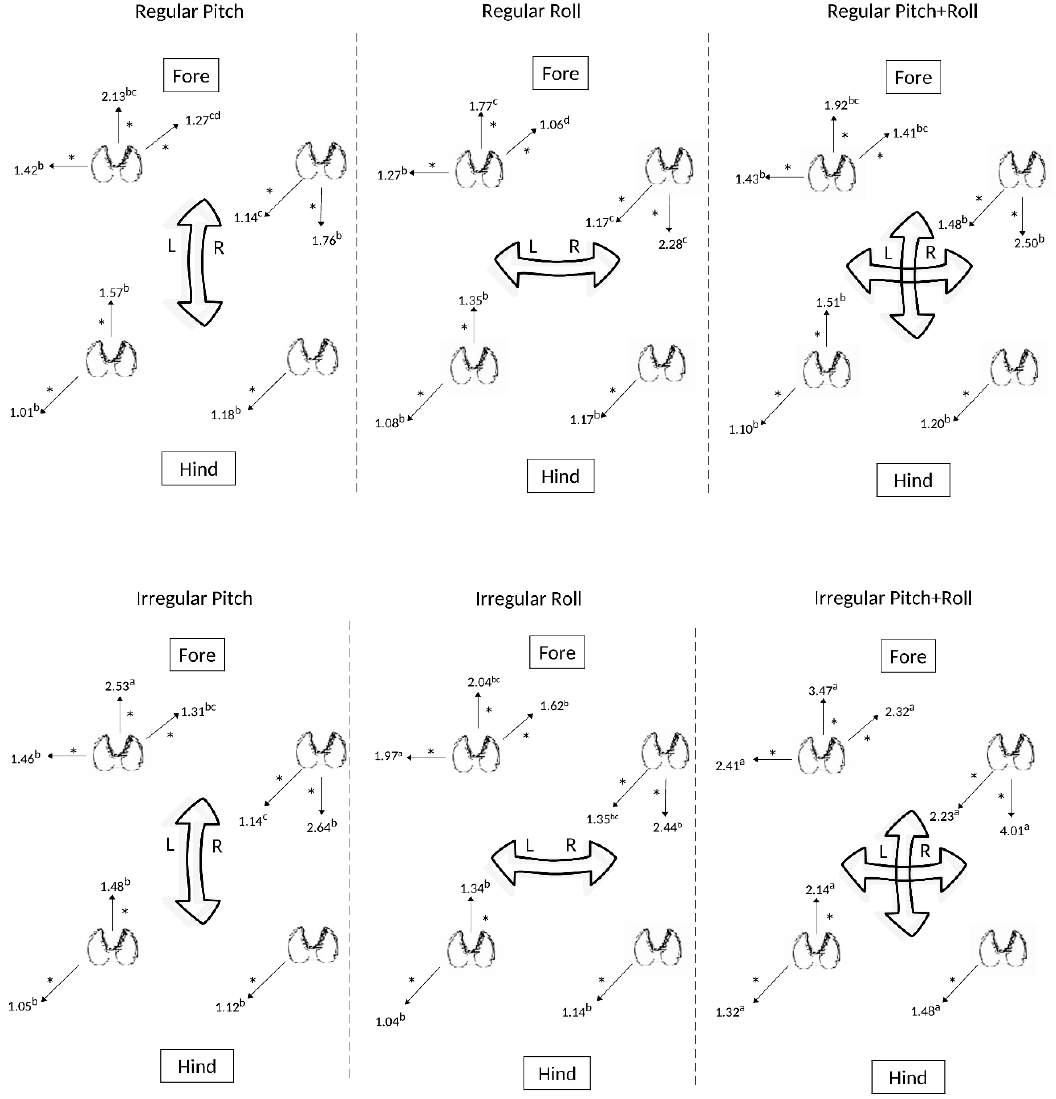
Figure 4. Effects of the type of regular and irregular sequences of floor movement (roll, pitch or the two combined) on stepping responses (steps/20 min) of the four limbs of sheep ( n = 6). Significantly different frequencies in stepping direction for each respective limb are presented (* p < 0.05; ** p < 0.02; *** p < 0.001). Different superscript letters (a,b,c,d,e,f) denote significantly different responses ( p < 0.05) observed for each individual limb.